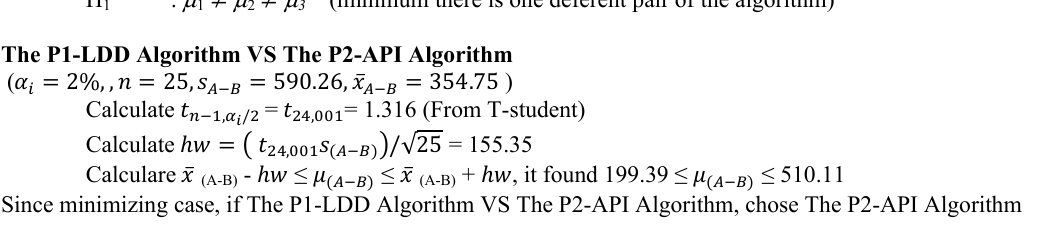
= 2% (i=1,2,3). The hypothesis is shown as follows. (cid:3036)